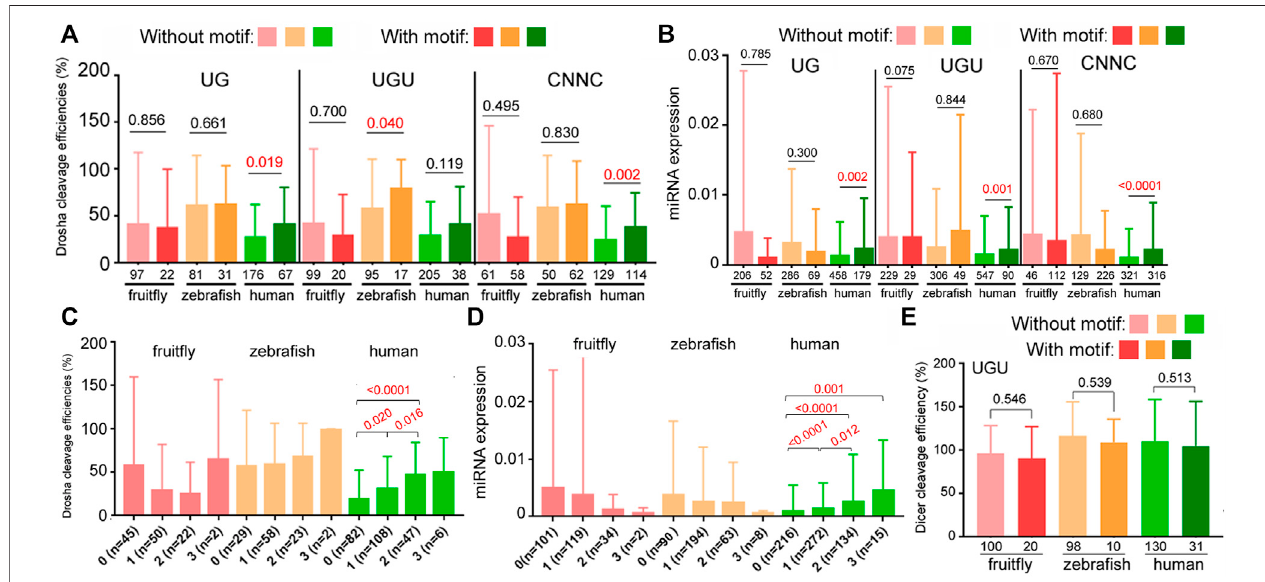
FIGURE 6 | Contributions by UG, UGU, and CNNC motifs to Drosha processing and miRNA expression. (A) Comparison of relative Drosha cleavage ef fi ciencies (y-axis) of fruit fl y, zebra fi sh, and human pri-miRNAs with or without the UG, UGU, or CNNC motif (listed on top). Different colors represent different species (x-axis). ColumnsontheleftrepresentmiRNAswithoutthesequencemotif,thoseontherightwiththemotif.IntegersunderneaththecolumnsindicatenumbersofmiRNAsinthe categories. Averages and standard deviations are shown, and the P values shown above the columns, with those < 0.05 in red. (B) Normalized expression (y-axis) of fruit fl y, zebra fi sh, and human miRNAs (x-axis) with or without the UG, UGU, or CNNC motif (on top). Labels are the same as in (A) . (C) Comparison of relative Drosha cleavage ef fi ciencies (y-axis) of fruit fl y, zebra fi sh, and human pri-miRNAs with 0, 1, 2, or 3 of the UG, UGU, and/or CNNC motifs (x-axis). Labeling is the same as in (A) . Thevariouscategoriesareindicatedatthebottom,withnumbersofthemiRNAslistedinparentheses. (D) Normalizedexpression(y-axis)offruit fl y,zebra fi sh,andhuman miRNAs with 0, 1, 2, or 3 of the UG, UGU, and/or CNNC motifs (x-axis). Labels are the same as in (C) . (E) Comparison of relative Dicer cleavage ef fi ciencies (y-axis) of fruit fl y, zebra fi sh, and human pre-miRNAs with or without the UGU motif. Different colors represent different species (x-axis). Columns on the left represent miRNAs without the sequence motif, those on the right with the motif. Integers underneath the columns indicate numbers of miRNAs in the categories. Averages and standard deviations are shown, and the P values indicated above the columns.